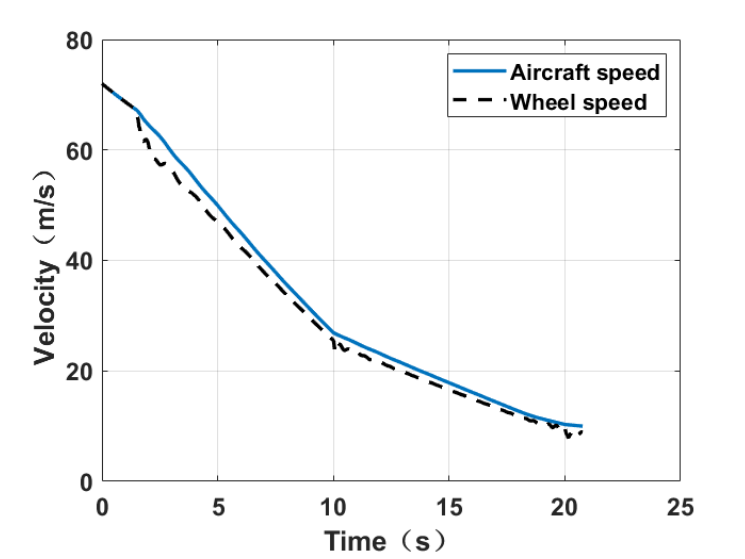
Figure 11. Aircraft speed and wheel speed curve on hybrid